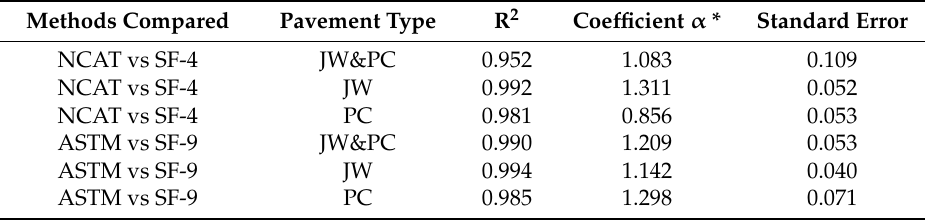
Table 2. Correlation between the permeability measurements obtained with different